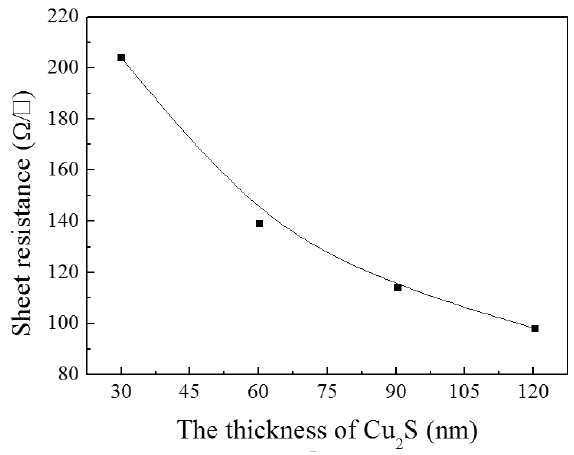
Figure 10. The sheet resistance of Cu 2 S/ZnO/glass complex films for different thickness.